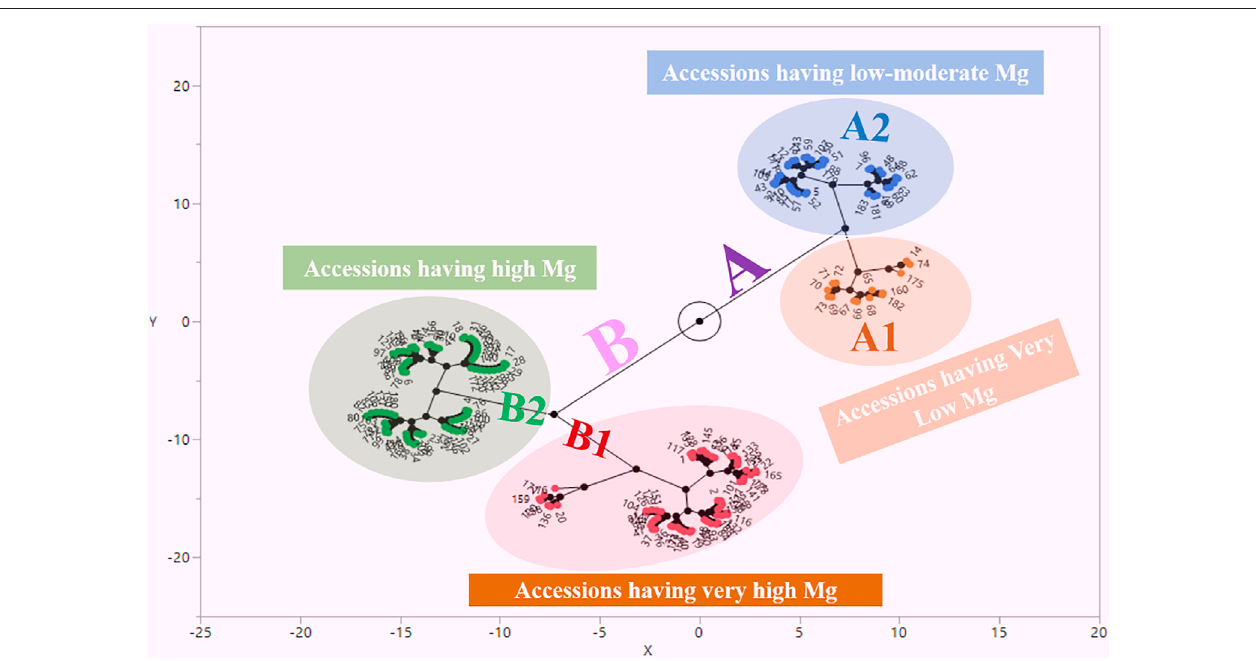
FIGURE 3 | Constellation plot for magnesium content in Turkish common bean germplasm.